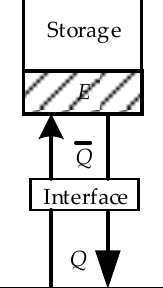
Figure 3. Energy storage device.